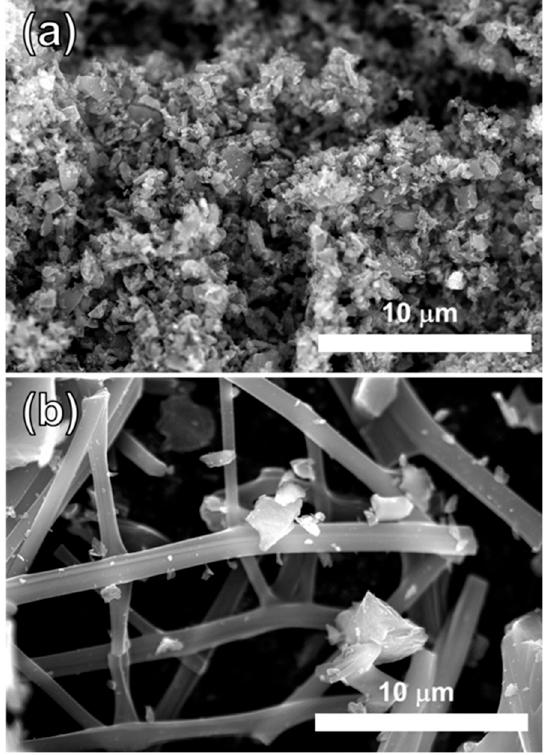
Figure 10. SEM images of MCF-A-800 ( a ) and MCF-A-450 ( b ).